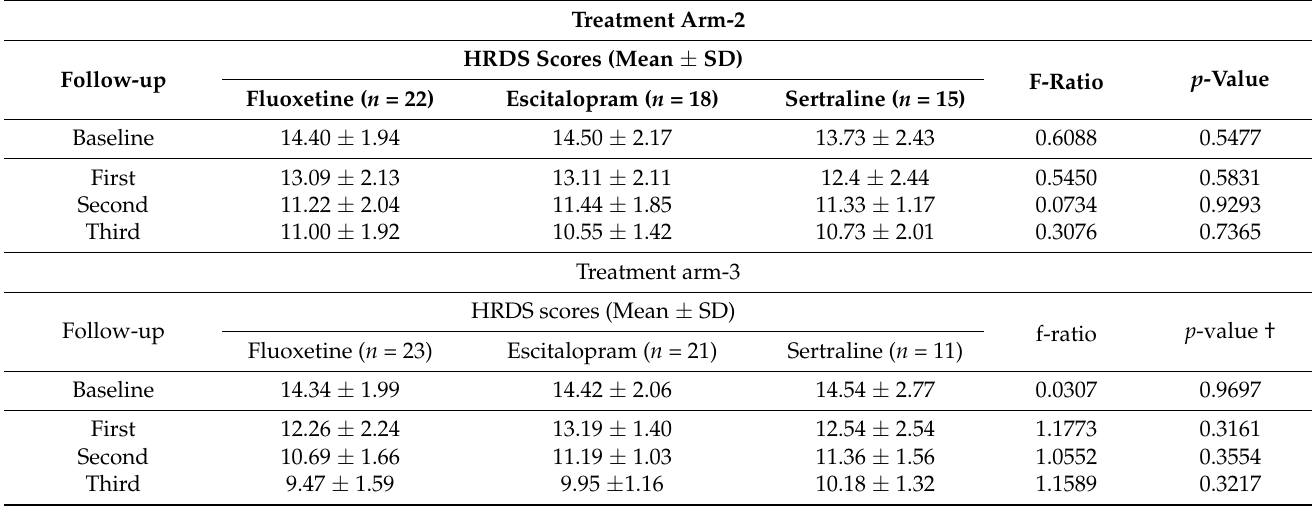
Table 5. Comparison of HRDS scores in patients using different antidepressants in treatment arm-2 and arm-3 from baseline to first, second and third follow-ups